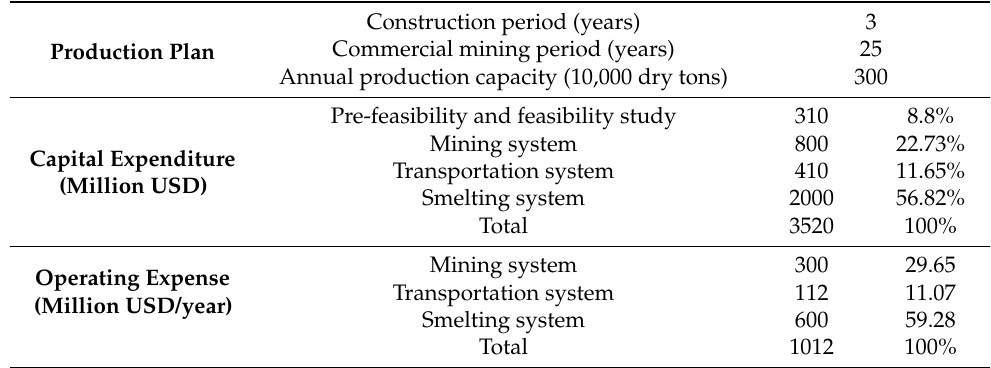
Figure 1. Schematic diagram of the polymetallic nodule exploration contract area of the China Ocean Mineral Resources Research and Development (R&D) Association (COMRA) (from http: //www.isa.org.jm (accessed on 10 April 2019)). Table 2. The main business parameters of the mining enterprises in the Central South University (CSU) 2019 model. USD, United States dollar.